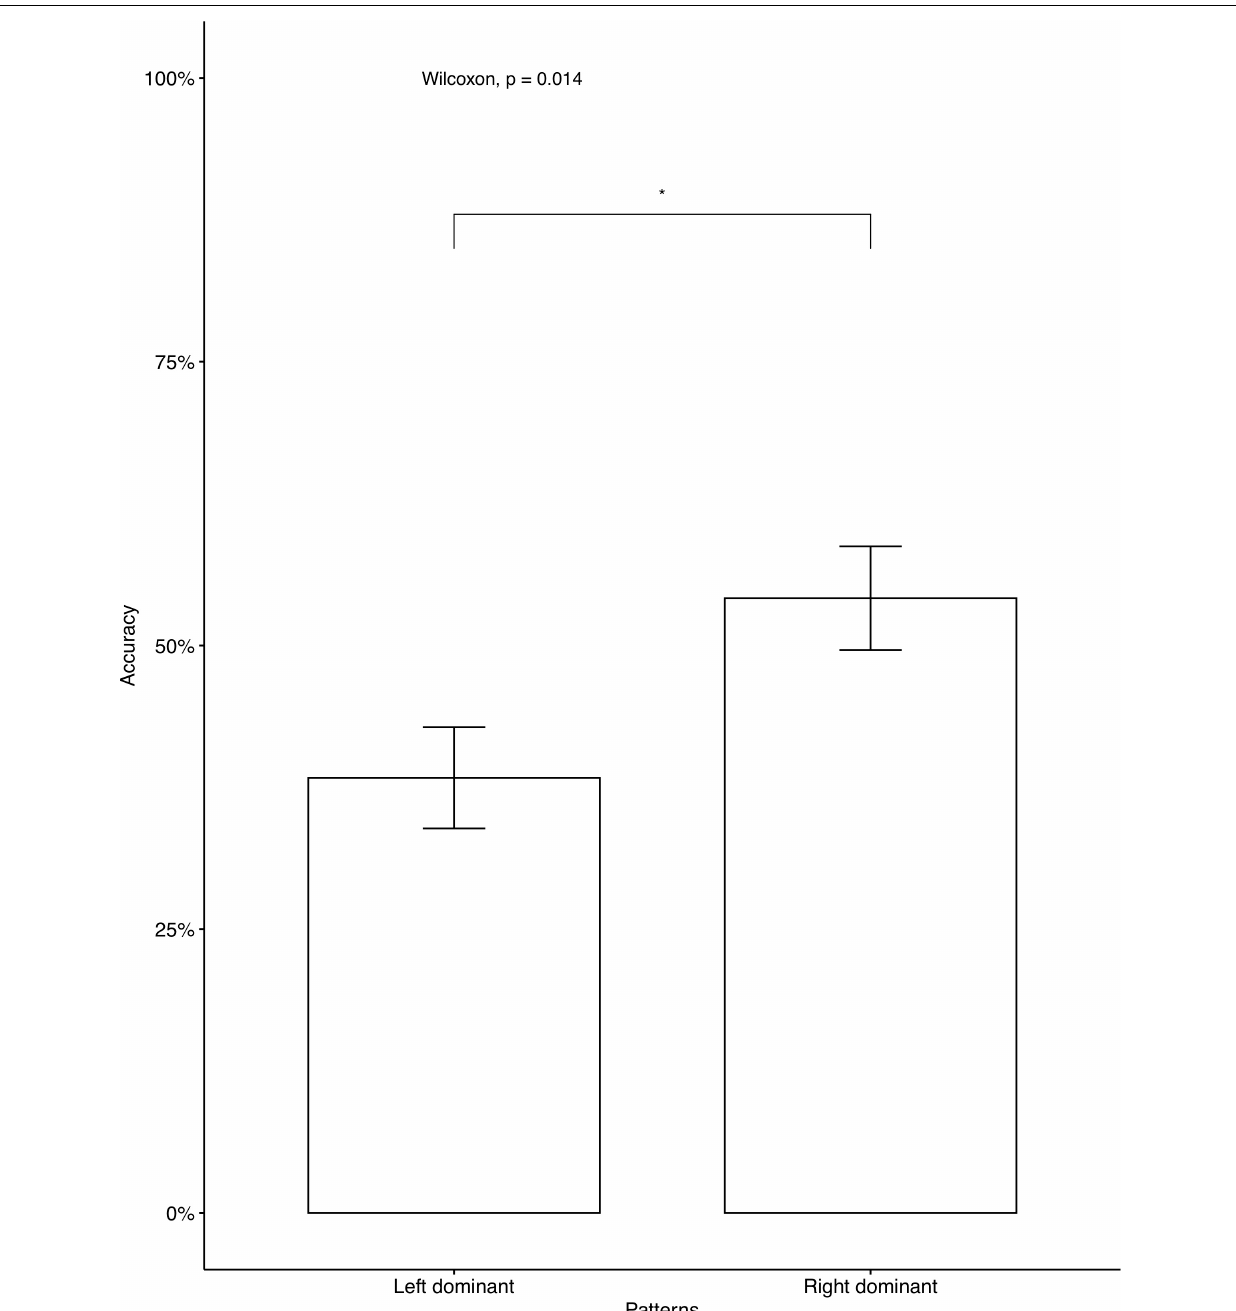
1 = correct response). Two sum coded factors, Simplicity (Uni- directional vs. Bi-directional) and Directionality (Neutral